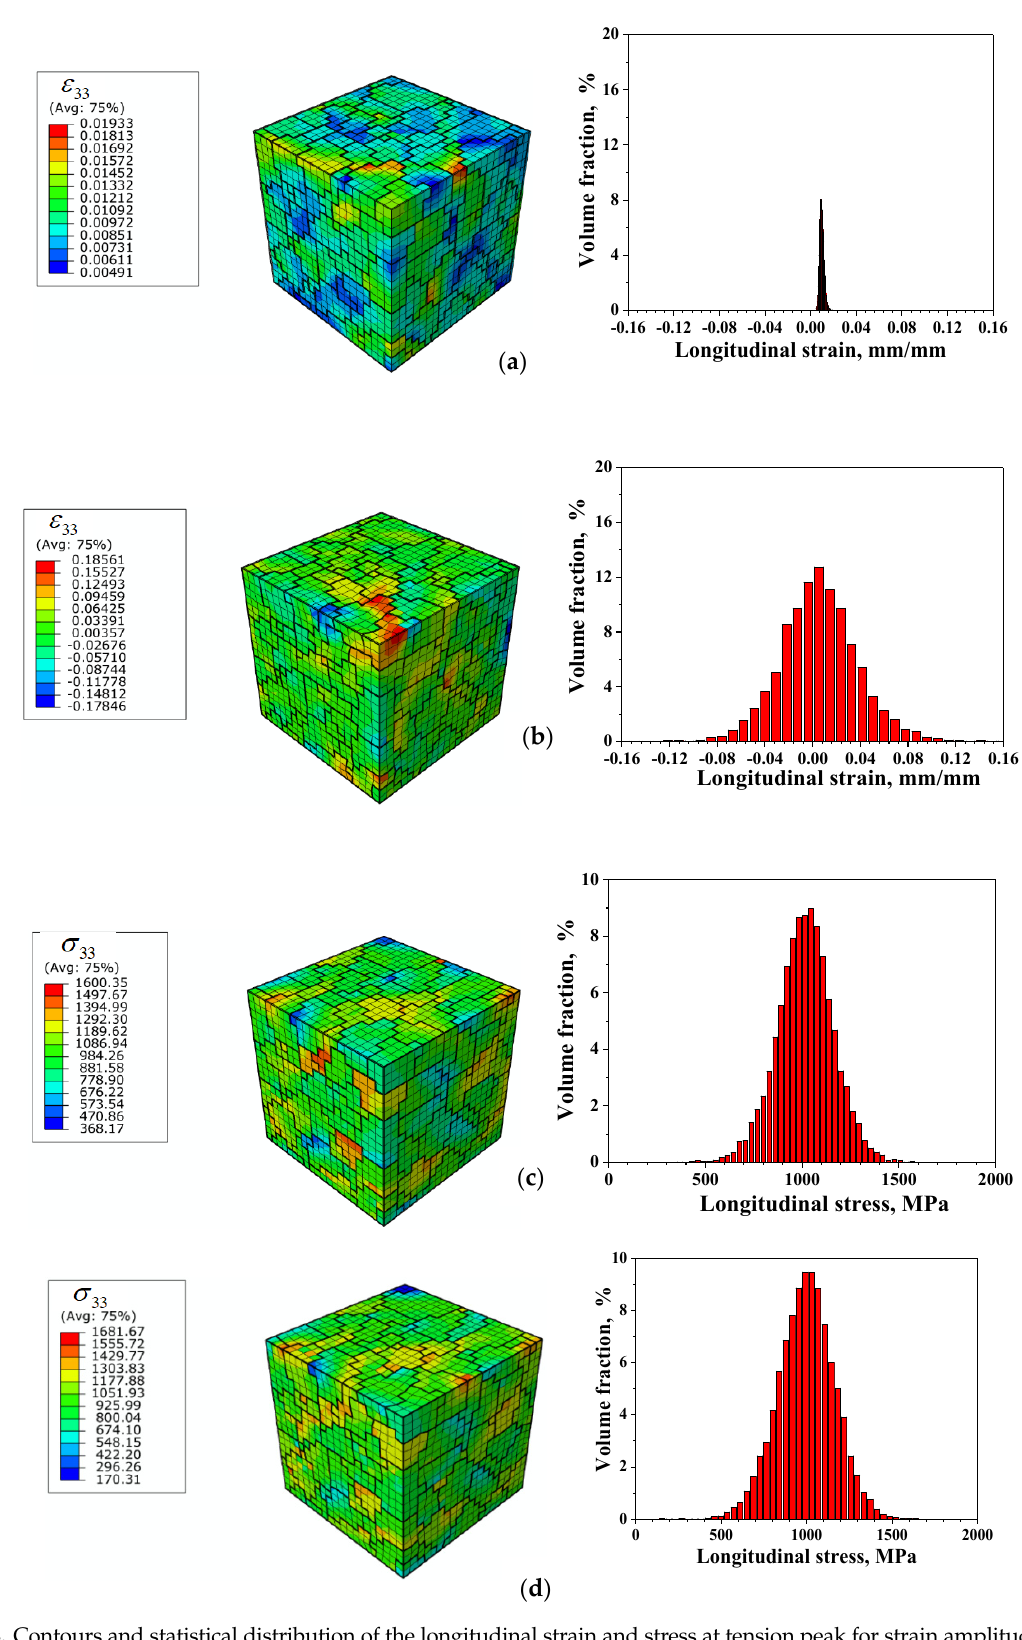
Figure 4. Contours and statistical distribution of the longitudinal strain and stress at tension peak for strain amplitude 0.01003: ( a ) and ( b ) for longitudinal strain at 3rd and 840th cycle, respectively; ( c ) and ( d ) for longitudinal stress at 3rd and 840th cycle, respectively.